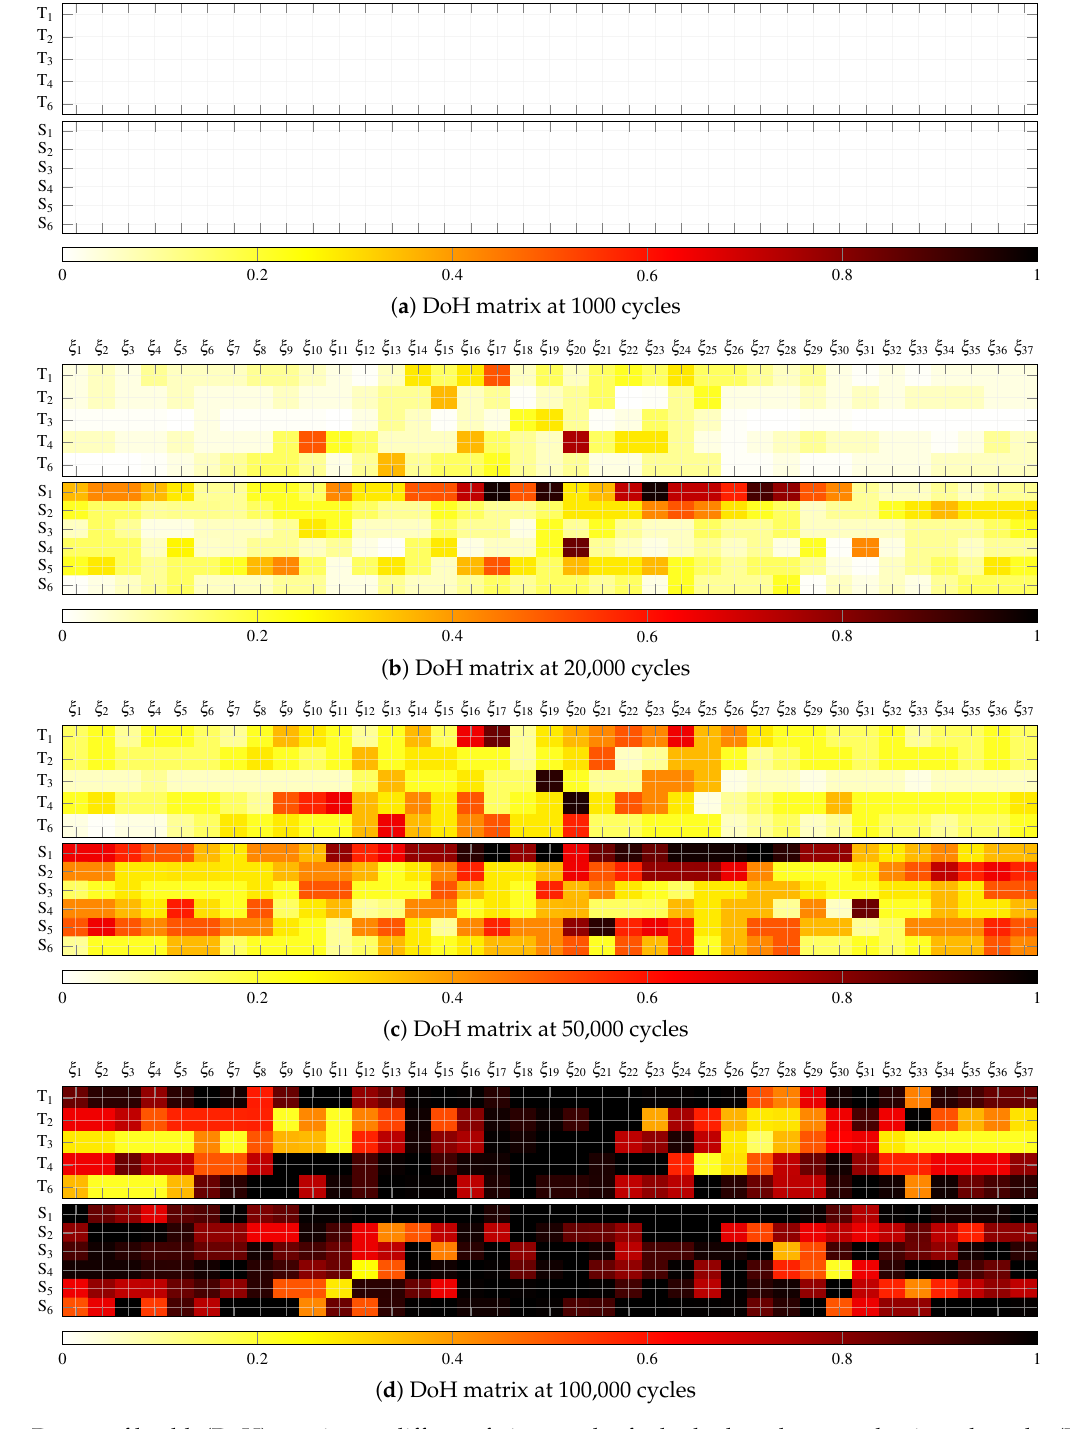
Figure 6. Degree of health (DoH) matrices at different fatigue cycles for both phased-arrays, that is, pulse-echo (T i ) and pitch-catch (S i